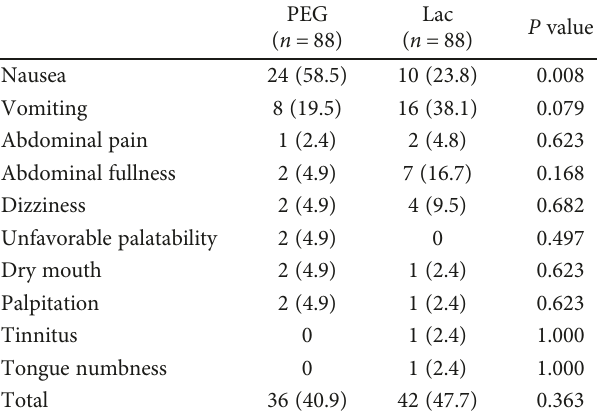
Table 7: Comparison of adverse events and tolerability, n